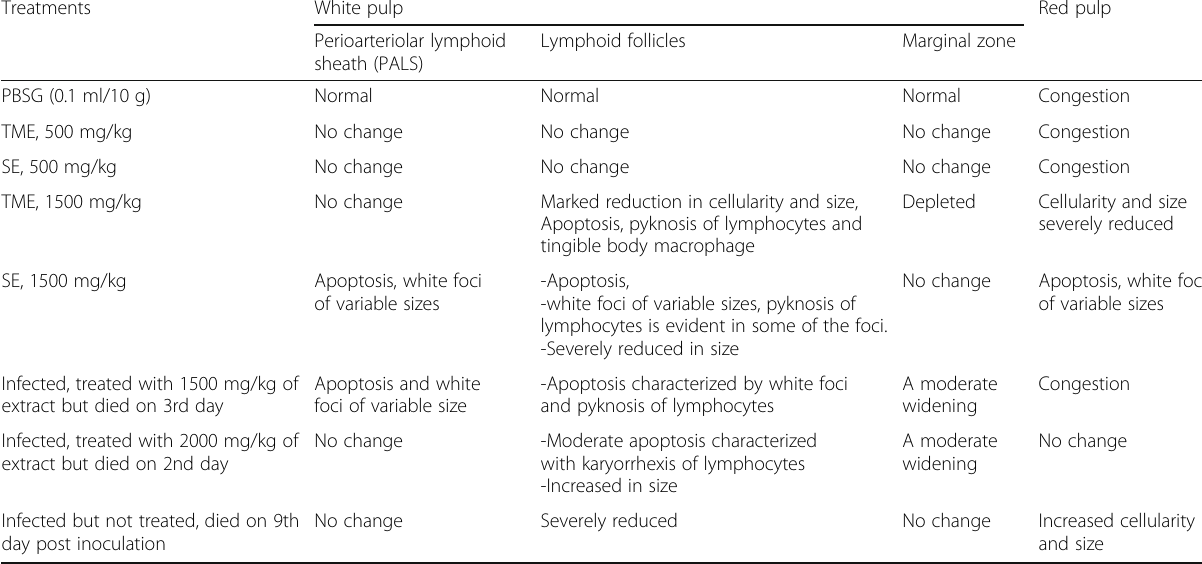
Table 3 Effect of C. swynnertonii ethanolic stem bark extract on spleen Treatments